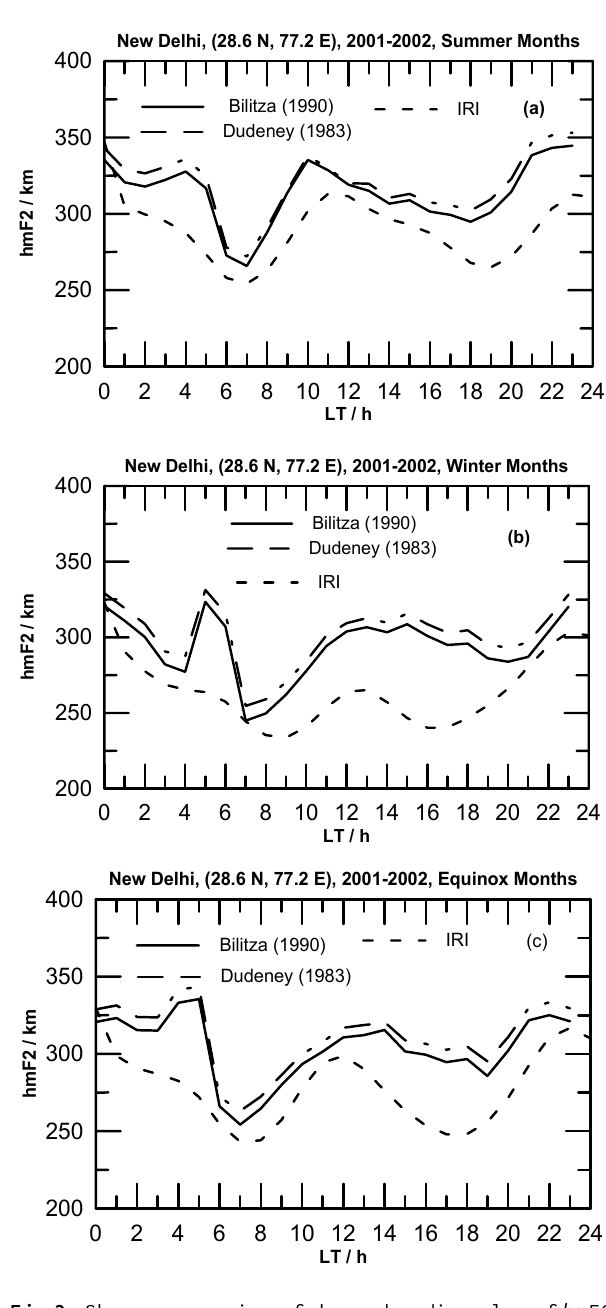
Fig. 3. Shows a comparison of observed median values of hm F2 Fig. 3 using Dudeney (1983) (shown as a double dashed line) and Bil- itza (1990) (shown as solid line) schemes, with those obtained from the IRI predicted (shown as dash line) model over New Delhi, 28.6 ◦ N, 77.2 ◦ E) for (a) summer, (b) winter and (c)